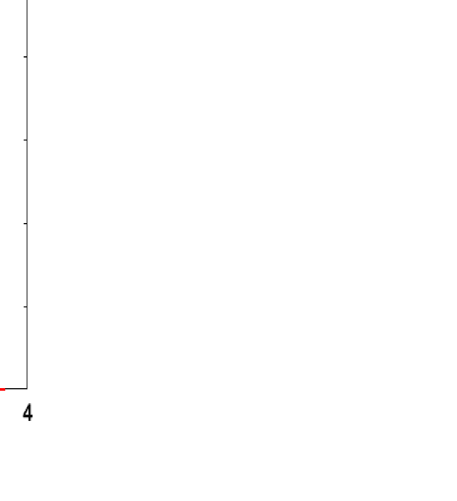
Figure 15. φ ( ζ ) for various S c